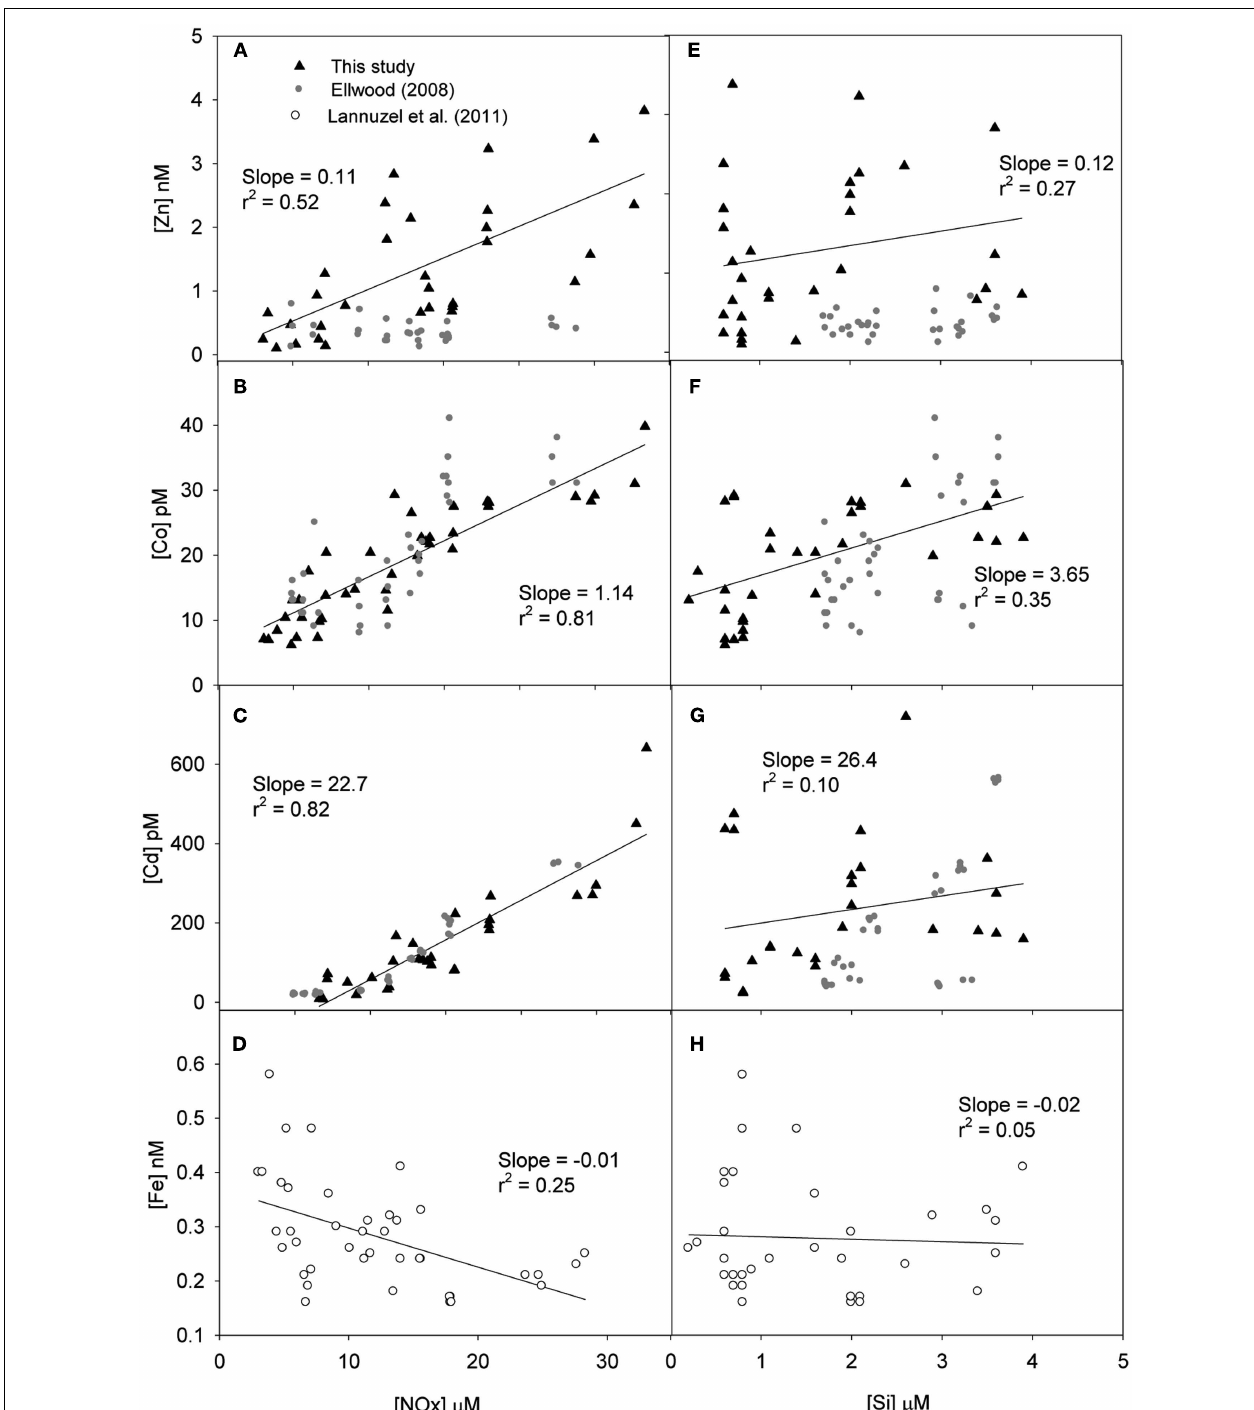
slope and the coefficient of correlation for linear regression are shown. Data from a previous study in the region is also shown (Ellwood, 2008). It is to be noted that Ellwood (2008) did not cross the North Polar Front into Antarctic Zone, which could explain some discrepancy. Data for Fe are from Lannuzel et al.